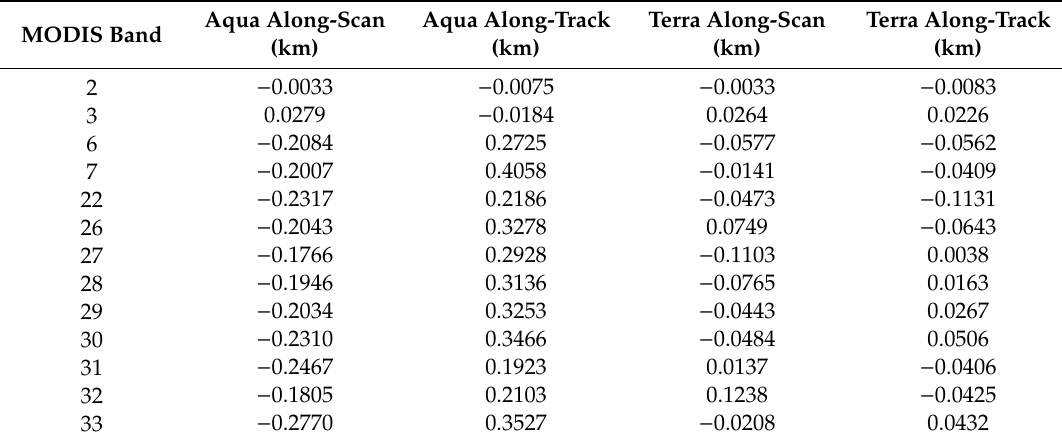
Table 2. MODIS band-to-band registration (BBR) o ff sets in kilometers with respect to MODIS band 1 for